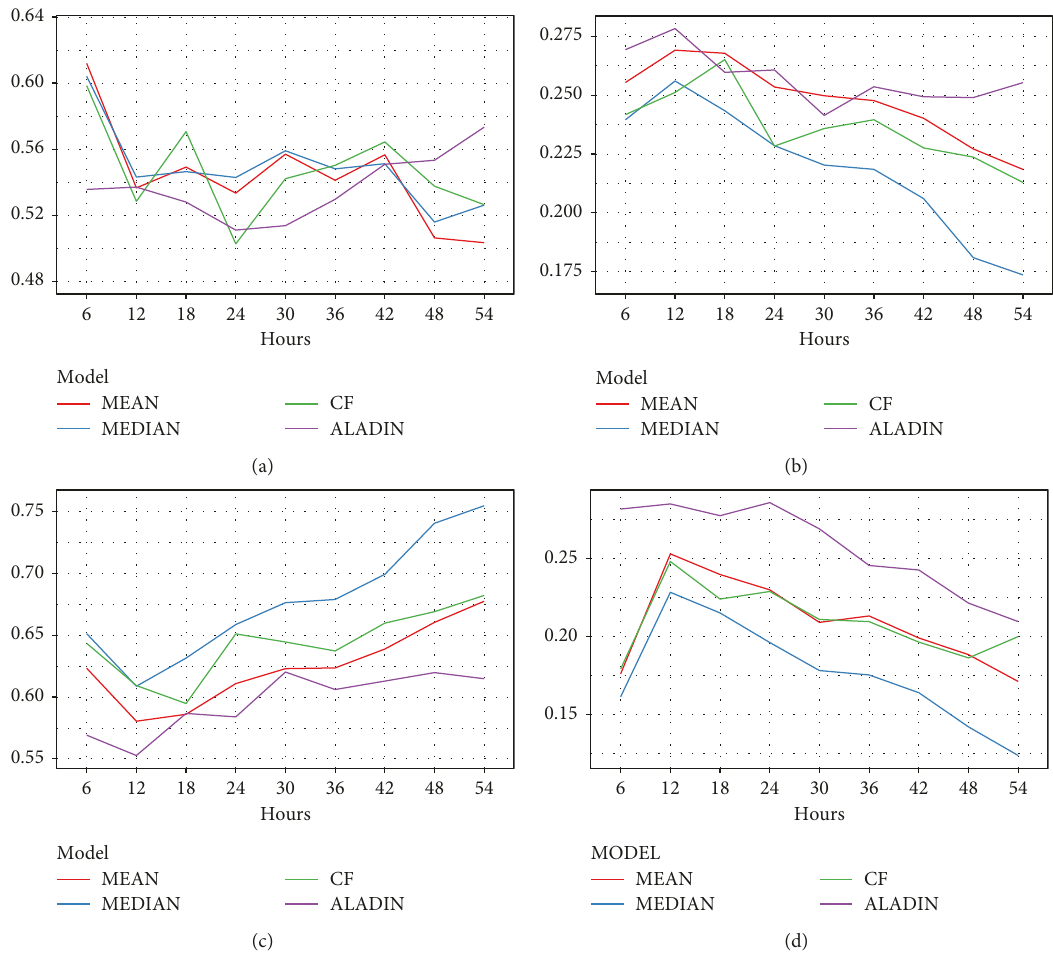
Figure 3: Comparison of ALADIN (purple), MEAN (red), MEDIAN (blue), and CF (green) for POD (a), TS (b), FAR (c), and POFD (d) as a function of lead time. Grey lines represent 16 ensemble